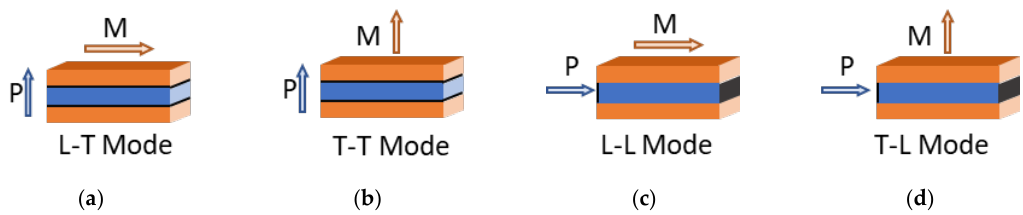
Figure 1. Four bimorph laminate orientation combinations. Orange indicates magnetostrictive (MS) material, blue the piezoelectric (PE) material, and black the location of the PE electrodes. Additionally, the letters in the mode names, T for transverse and L for longitudinal, indicate the orientation of the MS material and PE material, respectively. Compiled from [12–15]. ( a ): L-T Mode; ( b ) T-T Mode; ( c ) L-L Mode; ( d ) T-L Mode.